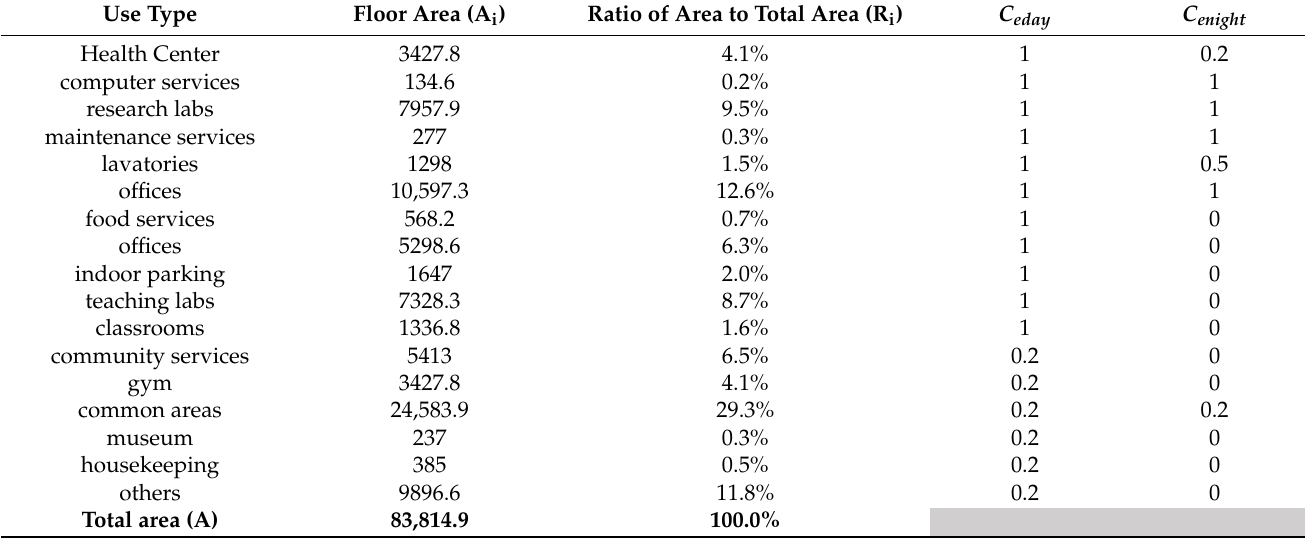
Table 3. Use categories and their floor areas in EV Building.